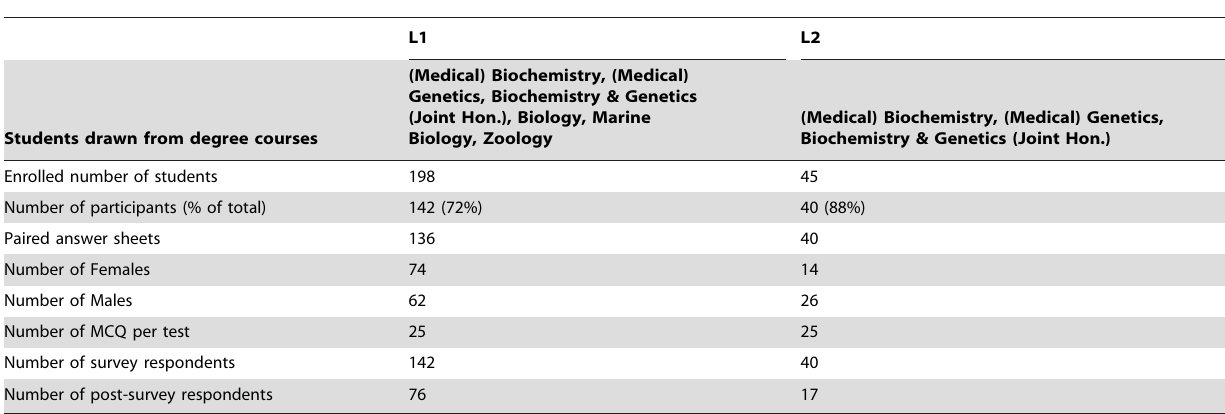
Table 1. Descriptive statistics of MCQ tests and student surveys.